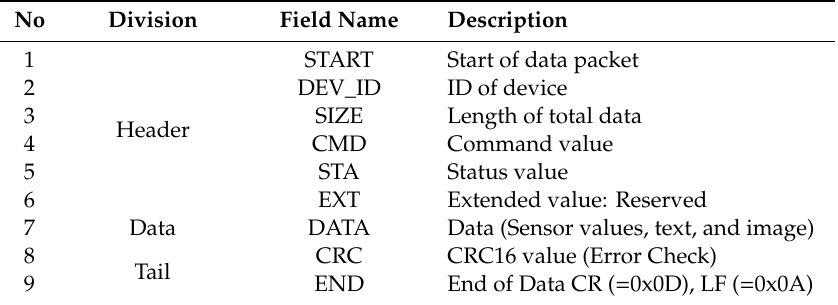
Table 2. Structure of DiverPAD data packet.